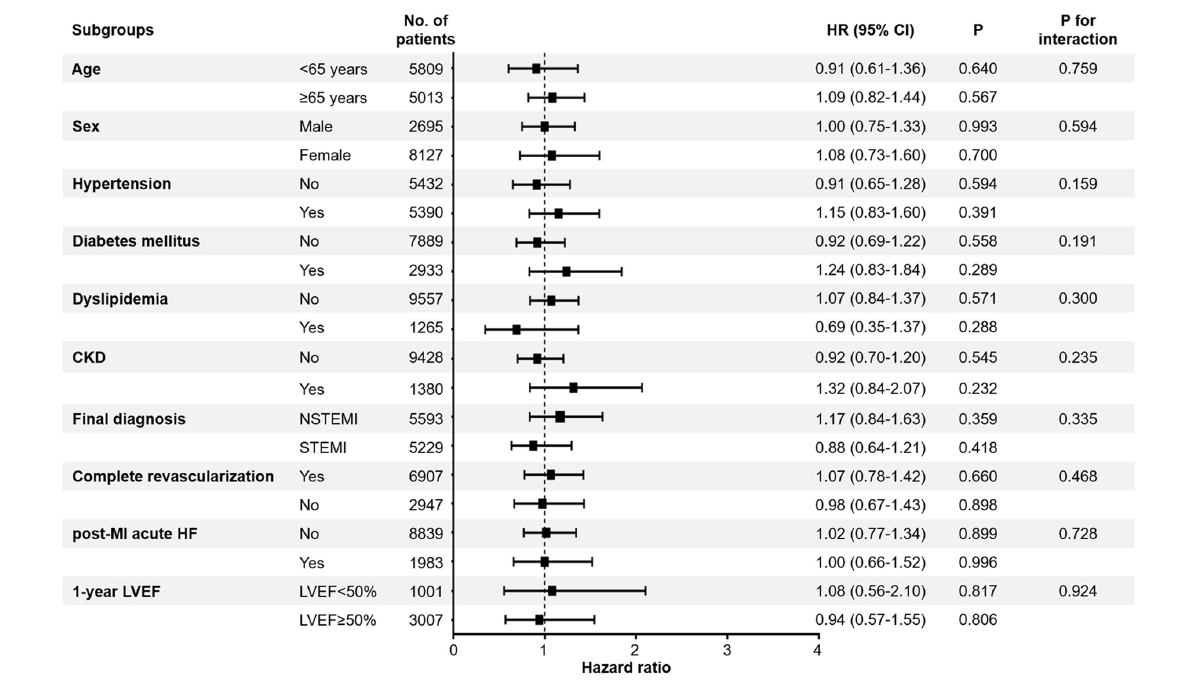
FIGURE5 Association between all-cause mortality and use of RASi. The effects of RASi at 1-year follow-up for 2-year all-cause mortality in the exploratory subgroups were analyzed. CI, confidence interval; HF, heart failure; HR, hazard ratio; LVEF, left ventricular ejection fraction; MI, myocardial infarction; RASi, renin-angiotensin-system inhibitor; STEMI, ST-segment elevation myocardial infarction; NSTEMI, non-ST-segment elevation myocardial infarction.